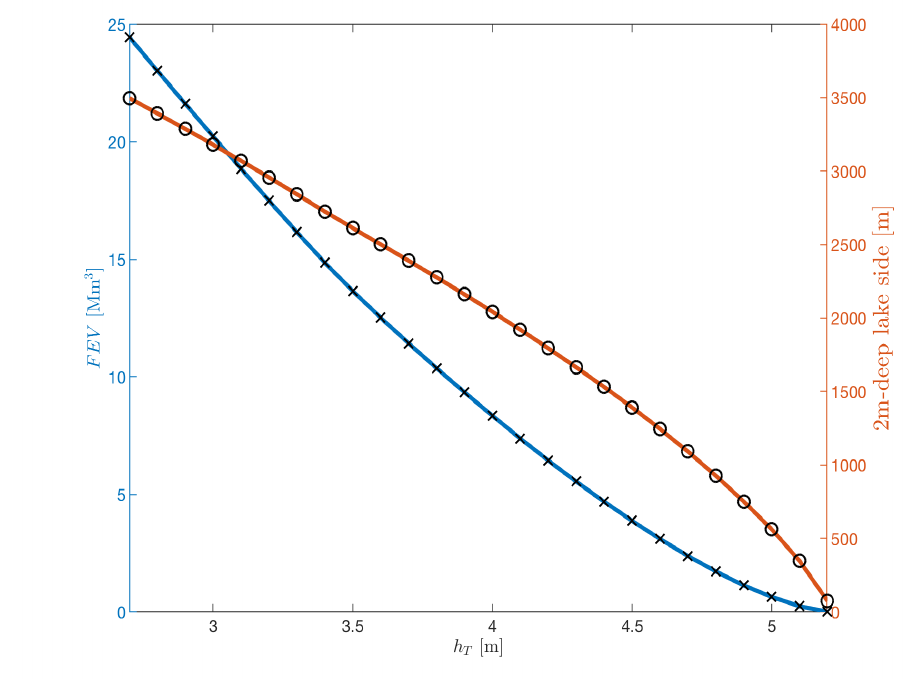
Figure 8. River Aire flood-excess volumes V e (left axis, crosses) and equivalent square-lake sizes (right axis, circles) for various threshold levels h T , from the Armley data of the Boxing Day 2015